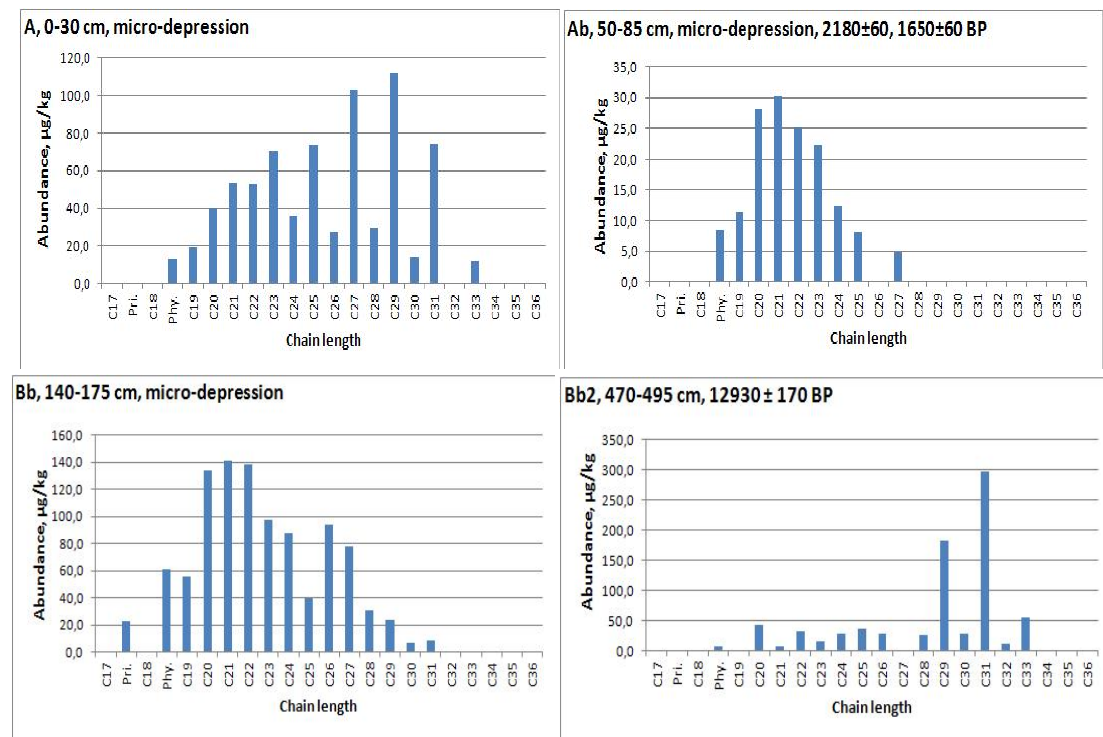
Figure 5. n ‐ alkane distribution in soil of micro ‐ elevation and interstadial soil from loess ‐ paleosol sequence under it.